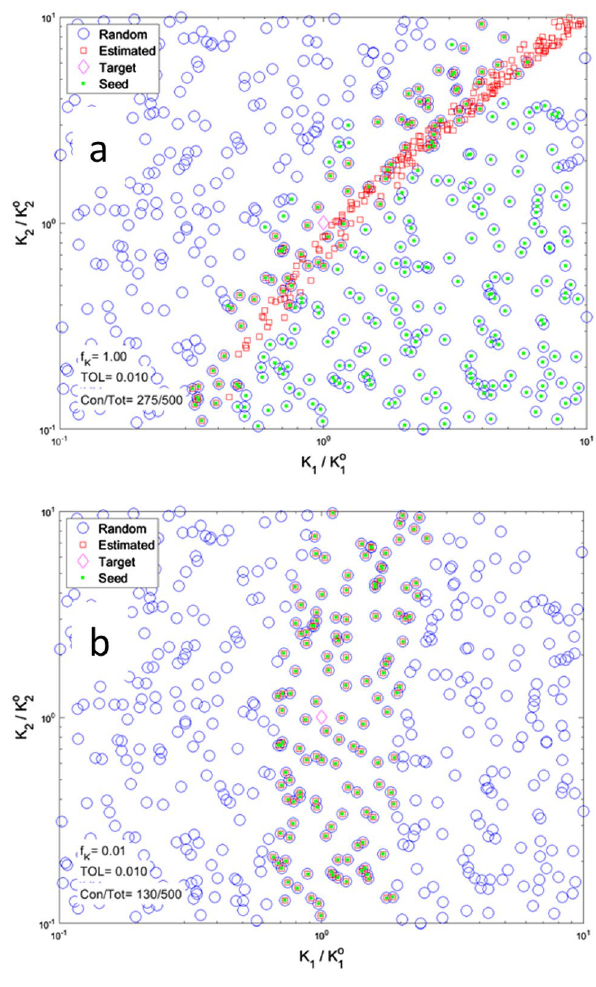
Fig. 4 Combinations of K 1 and K 2 assuming two different ratios, f K = 1.00, 0.01; for randomly selected values within specified range (blue dots) and after parameter estimation (red squares). Green dots show initial parameter values (seed) for the cases for which convergence criteria was satisfied. a Homogeneous and b hetero- geneous